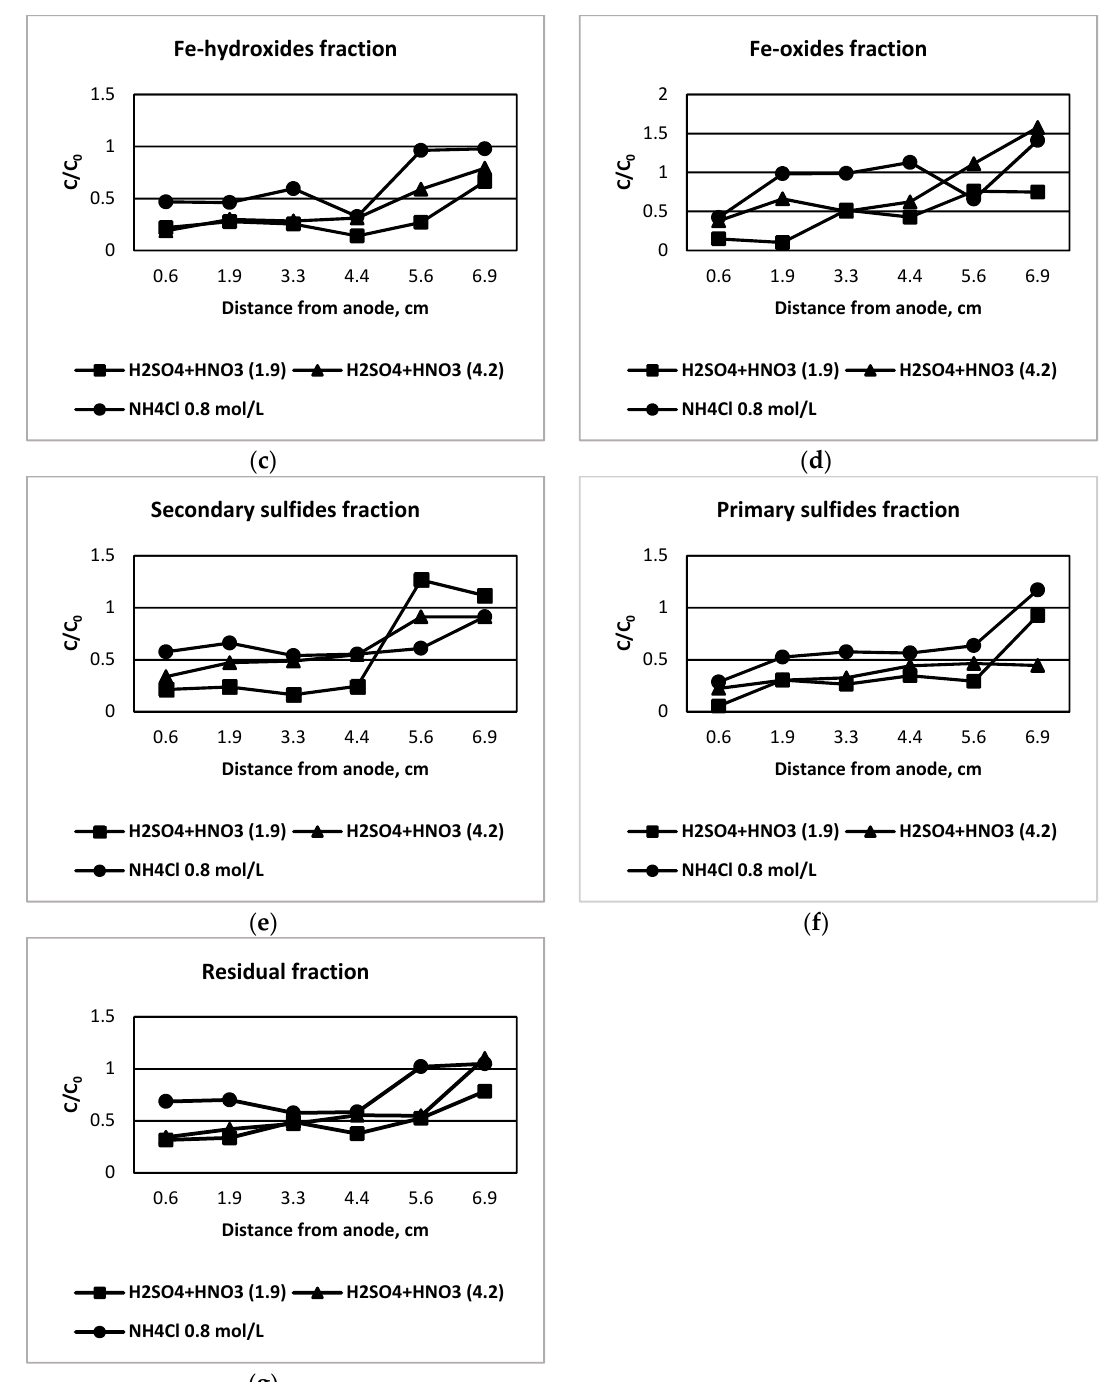
Figure 2. C/C 0 ratio of copper concentration for slices closest to anode and closest to cathode for different pre-treatment solutions after electrodialytic remediation. Analysis of the seven-fraction procedure, where the fractions are: ( a ) water soluble fraction, ( b ) exchangeable fraction, ( c ) Fe-hydroxides fraction, ( d ) Fe-oxides fraction, ( e ) secondary sulfides fraction, ( f ) primary sulfides fraction and ( g ) residual fraction.